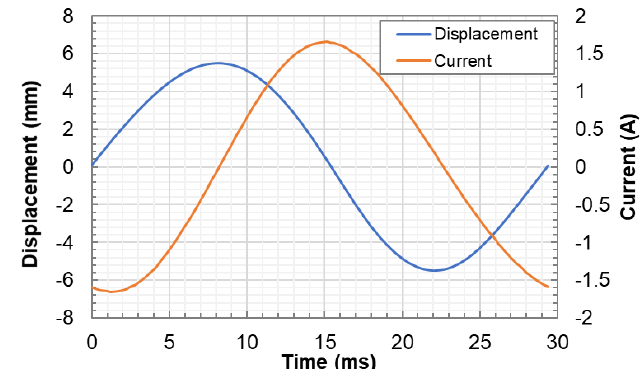
Figure 5. Measured displacement and current in one cycle at a stroke of 11 mm and a frequency of 34 Hz in steady-state.